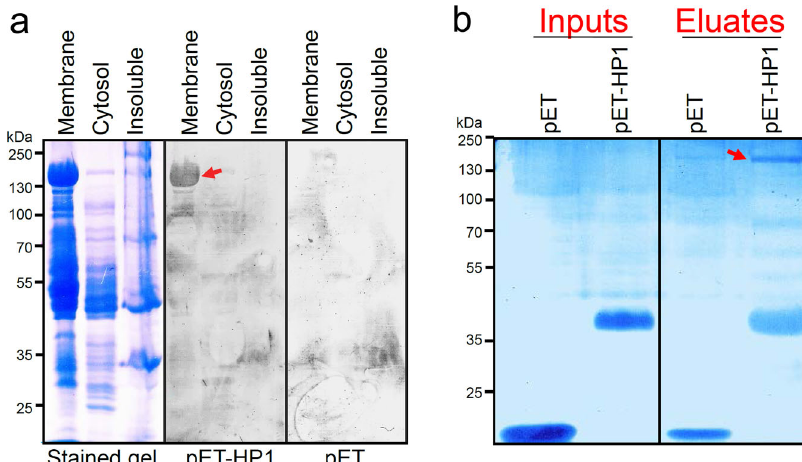
Fig. 7 The HP1 peptide and recombinant PLS bind to a ~160 kDa hepatocyte membrane protein. a Far-Western blotting assay of mouse primary hepatocyte fractions using recombinant pET-HP1 peptide or 19 kDa empty pET tag protein as a control. Recombinant pET-HP1 binding to a ~160 kDa hepatocyte membrane protein (red arrow) was detected with an anti-tag antibody. b Primary mouse hepatocyte membrane proteins were incubated either with empty recombinant pET tag or recombinant pET-HP1 peptide. The pET-HP1 peptide speci fi cally pulled down a ~160 kDa mouse hepatocyte membrane protein (red arrow). Coomassie blue-stained gel. a and b Each image represents two independent repeats. Source data are provided as a Source Data fi le.